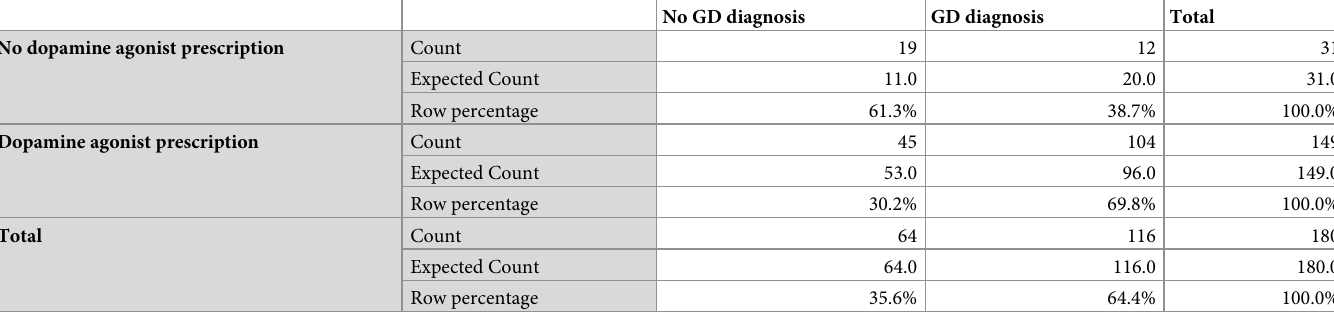
Table 1. Frequency counts and row percentages for dopamine agonist prescriptions and GD diagnoses in patients with any dopaminergic prescription.